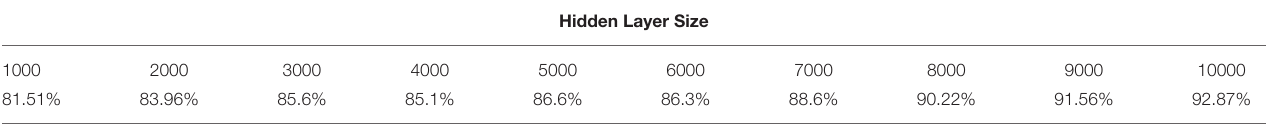
TABLE 2 | Results for classification of N-MNIST with larger hidden layer sizes.